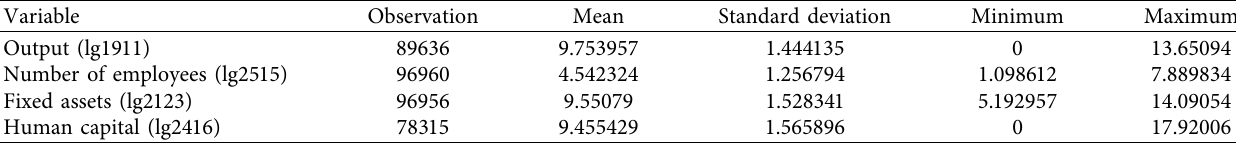
Table 3: Descriptive statistics on the variables of industrial enterprises in Hubei.